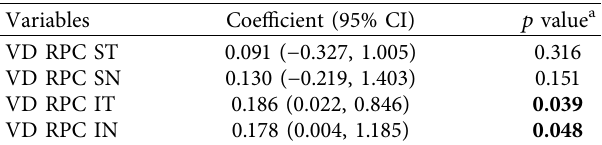
a Analyzed with univariate linear analysis. VD: vessel density; RPC: radial peripapillary capillary network; ST: superior temporal sector; SN: superior nasal sector; IT: inferior temporal sector; IN: inferior nasal